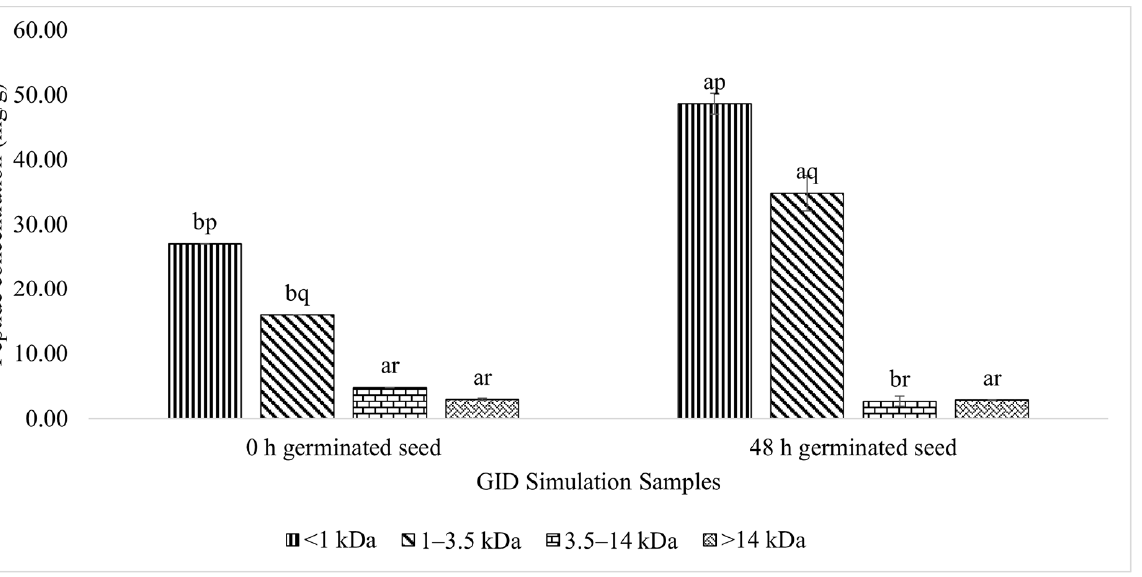
Figure 4. MW distribution of the germinated lamtoro gung flour peptide in different fractions after the GID simulation. Values are means with their SDs. a and b letters indicate significant differences between the same peptide fraction in different samples ( t -test, α = 0.05). p, q, and r indicate significant differences between the different peptide fractions in the same sample (Duncan’s test, α = 0.05). 3.3.3. ACE-I Activity of Each Peptide Fraction